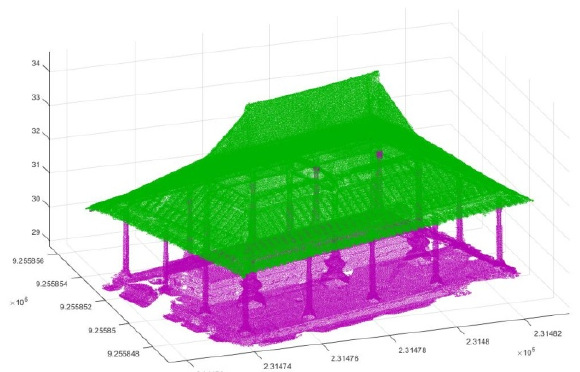
Figure 4. Automatically segmented building attic and body for the Kasepuhan Royal Pavilion dataset; the attic is here shown in green and the body in